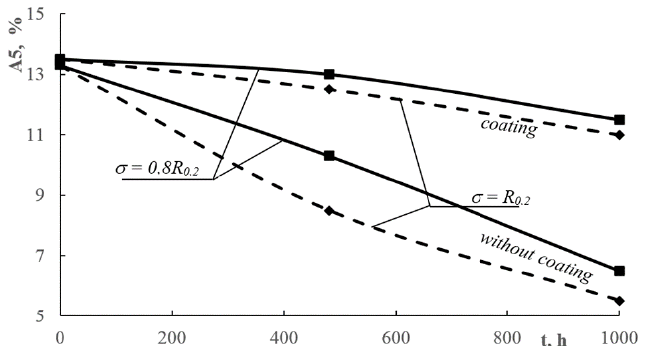
Figure 9. Influence of the corrosive environment and stress level on the tensile strength reduction of Figure 9 AlMg6 alloy samples without coatings and with coatings.